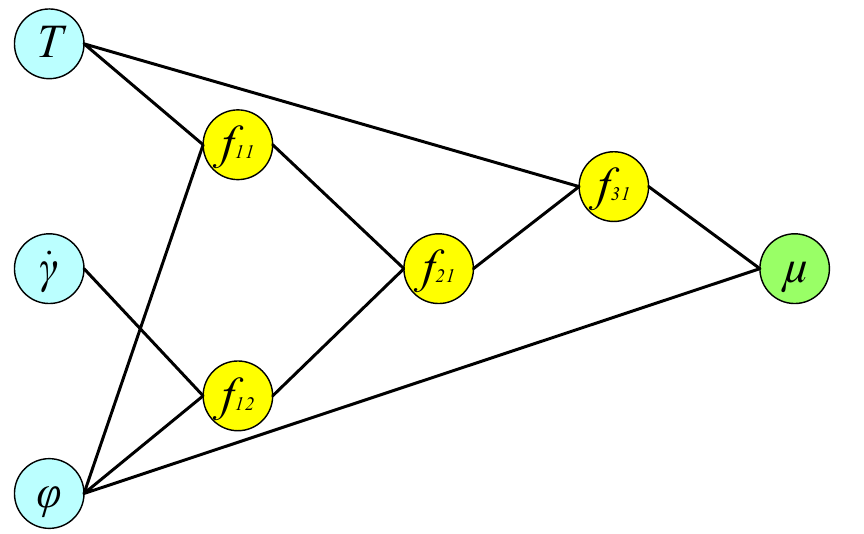
Figure 11. Structure of the developed GMDH-type ANN